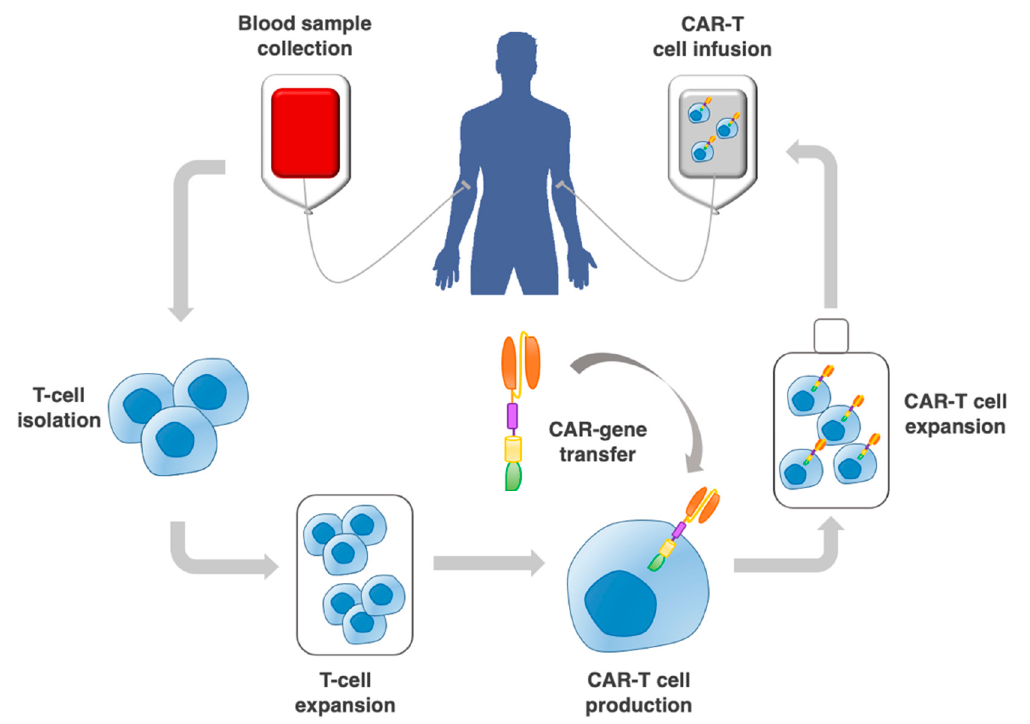
Figure 1. Procedure to implement adoptive CAR-T cell therapy. This includes the collection of a patient blood sample; T cell selection by leukapheresis from peripheral blood; CAR–gene transfer through a vector; expansion of CAR-T cells in vitro, and re-infusion into the patient.